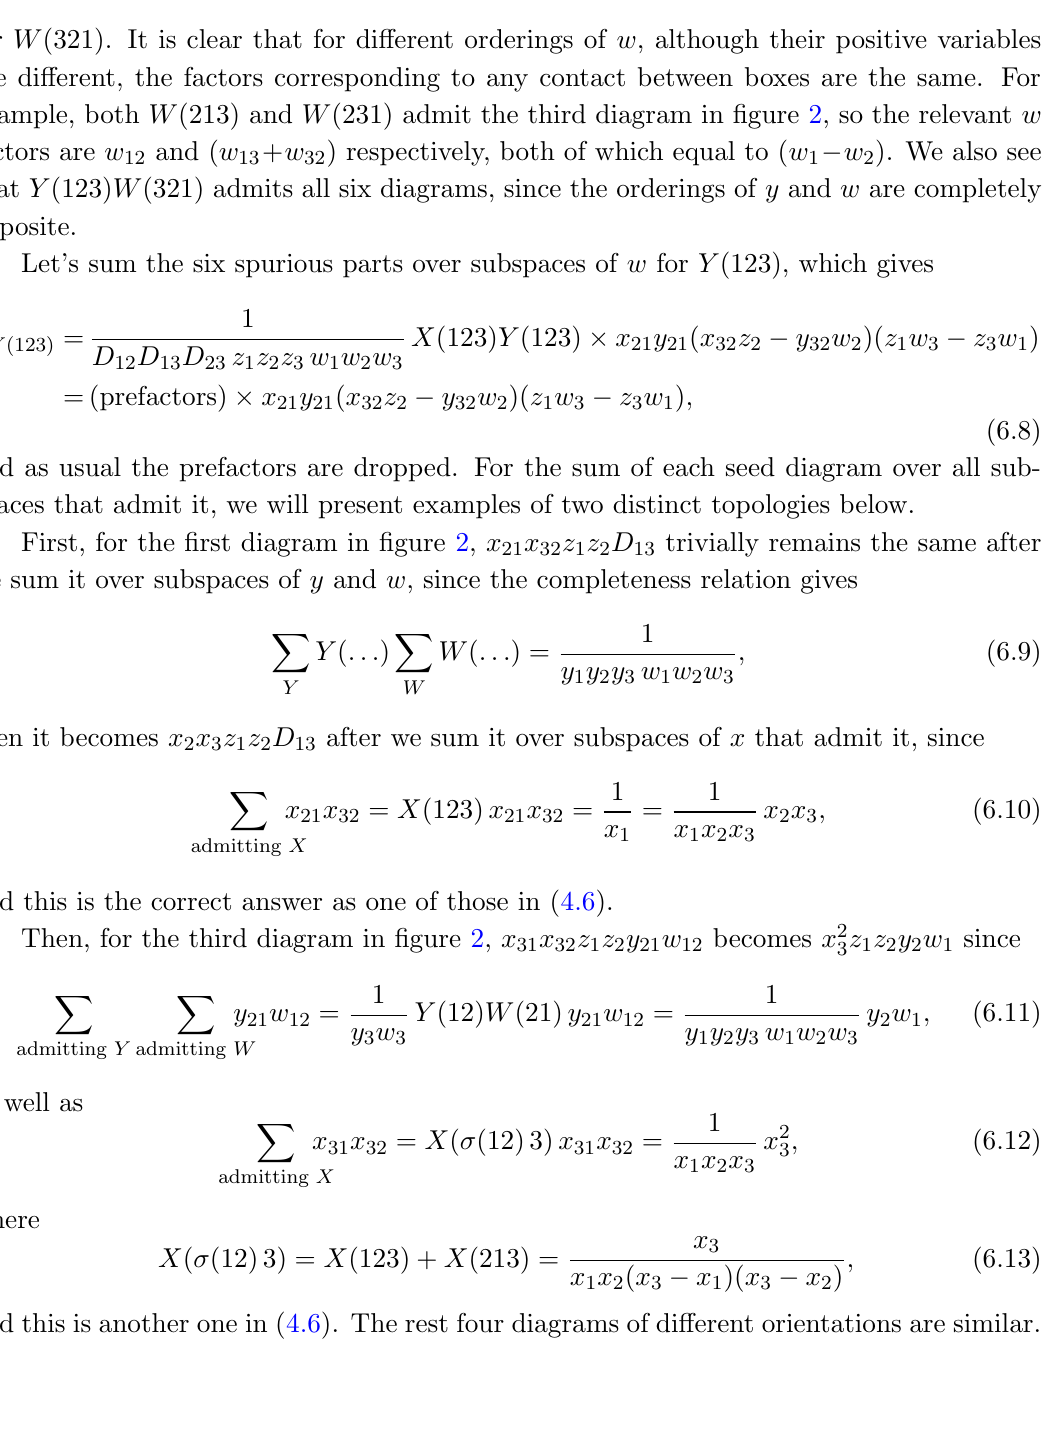
Figure 3 . Legal seed diagrams in X (123) of which some boxes are kept